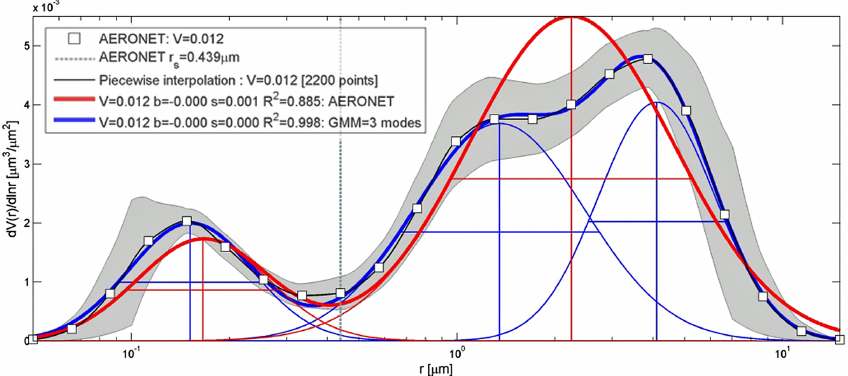
Fig. 5. Comparison of the interpolated AVSD for dominant marine (sea salt) aerosol at Lanai, Hawaii, on 21 January 2002 with the AERONET bi-lognormal fit and the optimal tri-modal Gaussian mixture model (GMM) fit. The grey band is the uncertainty on the AERONET